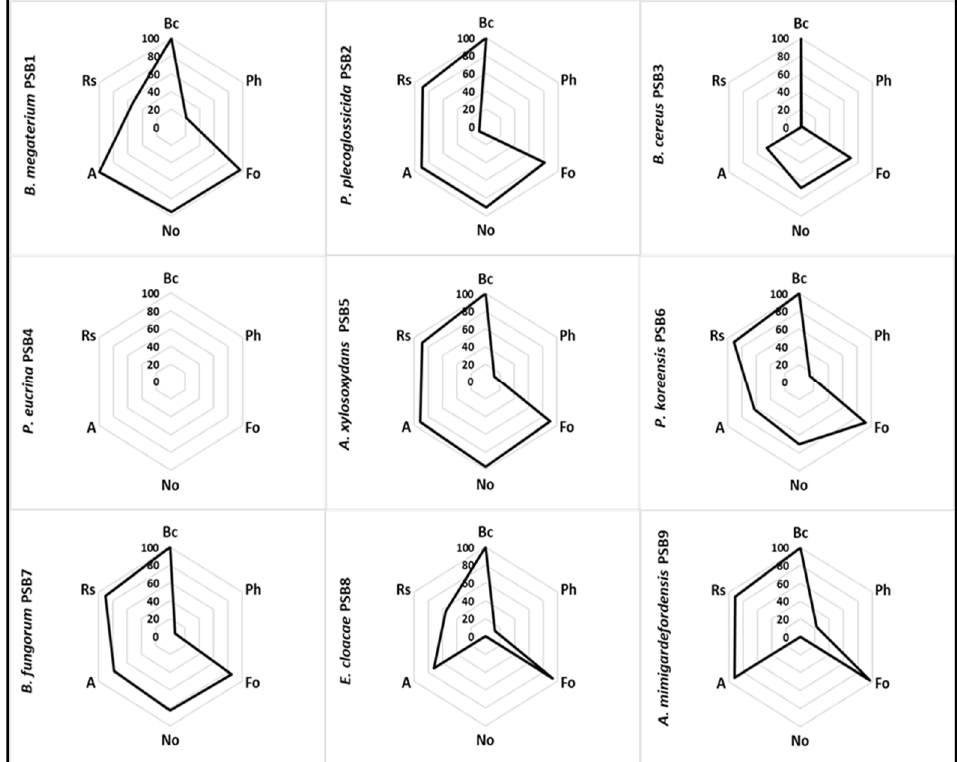
Figure 2. Antifungal activity of isolates PSB1 to PSB9 as determined by an in vitro bioassay (dual culture technique) on ISP5 medium. Average Inhibition index (I index) from three independent experiments are shown on a 0–100 scale. Bioassays were carried out against several phytopathogenic fungi: B. cinerea (Bc); P. herbarum (Ph); F. oxysporum (Fo); N. oryzae (No); Alternaria sp. (A); R. solani (Rs). Data shown were measured for each pathogen at different times when the Rc value of the negative control (pathogen growth in absence of antagonist PSB isolate) was 4.5 cm.